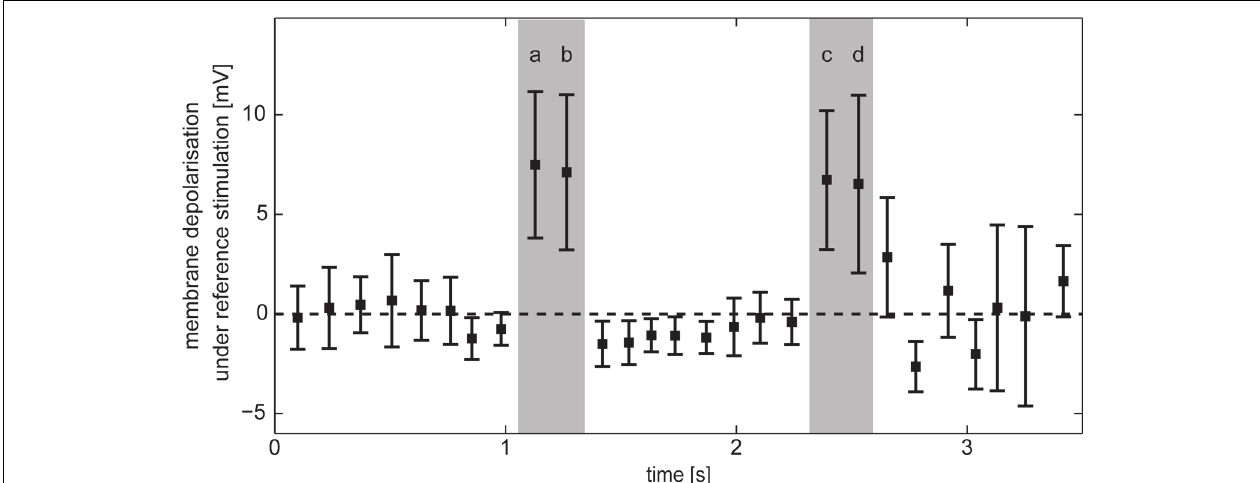
FIGURE 4 | Horizontal system response in intersaccadic intervals recorded during stimulation with the reference stimulus. Average responses during individual intersaccadic intervals with the standard deviation across the recordings of HS cells ( n = 23). Selected “object response intervals” are marked gray.